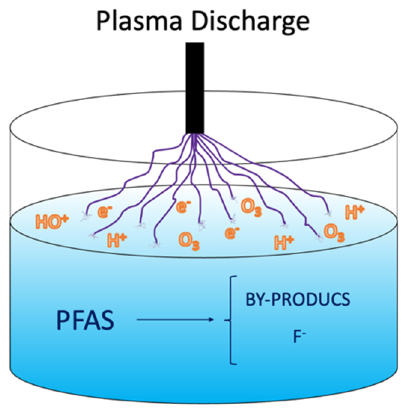
Figure 3. Non-thermal plasma approach for PFAS mineralization.